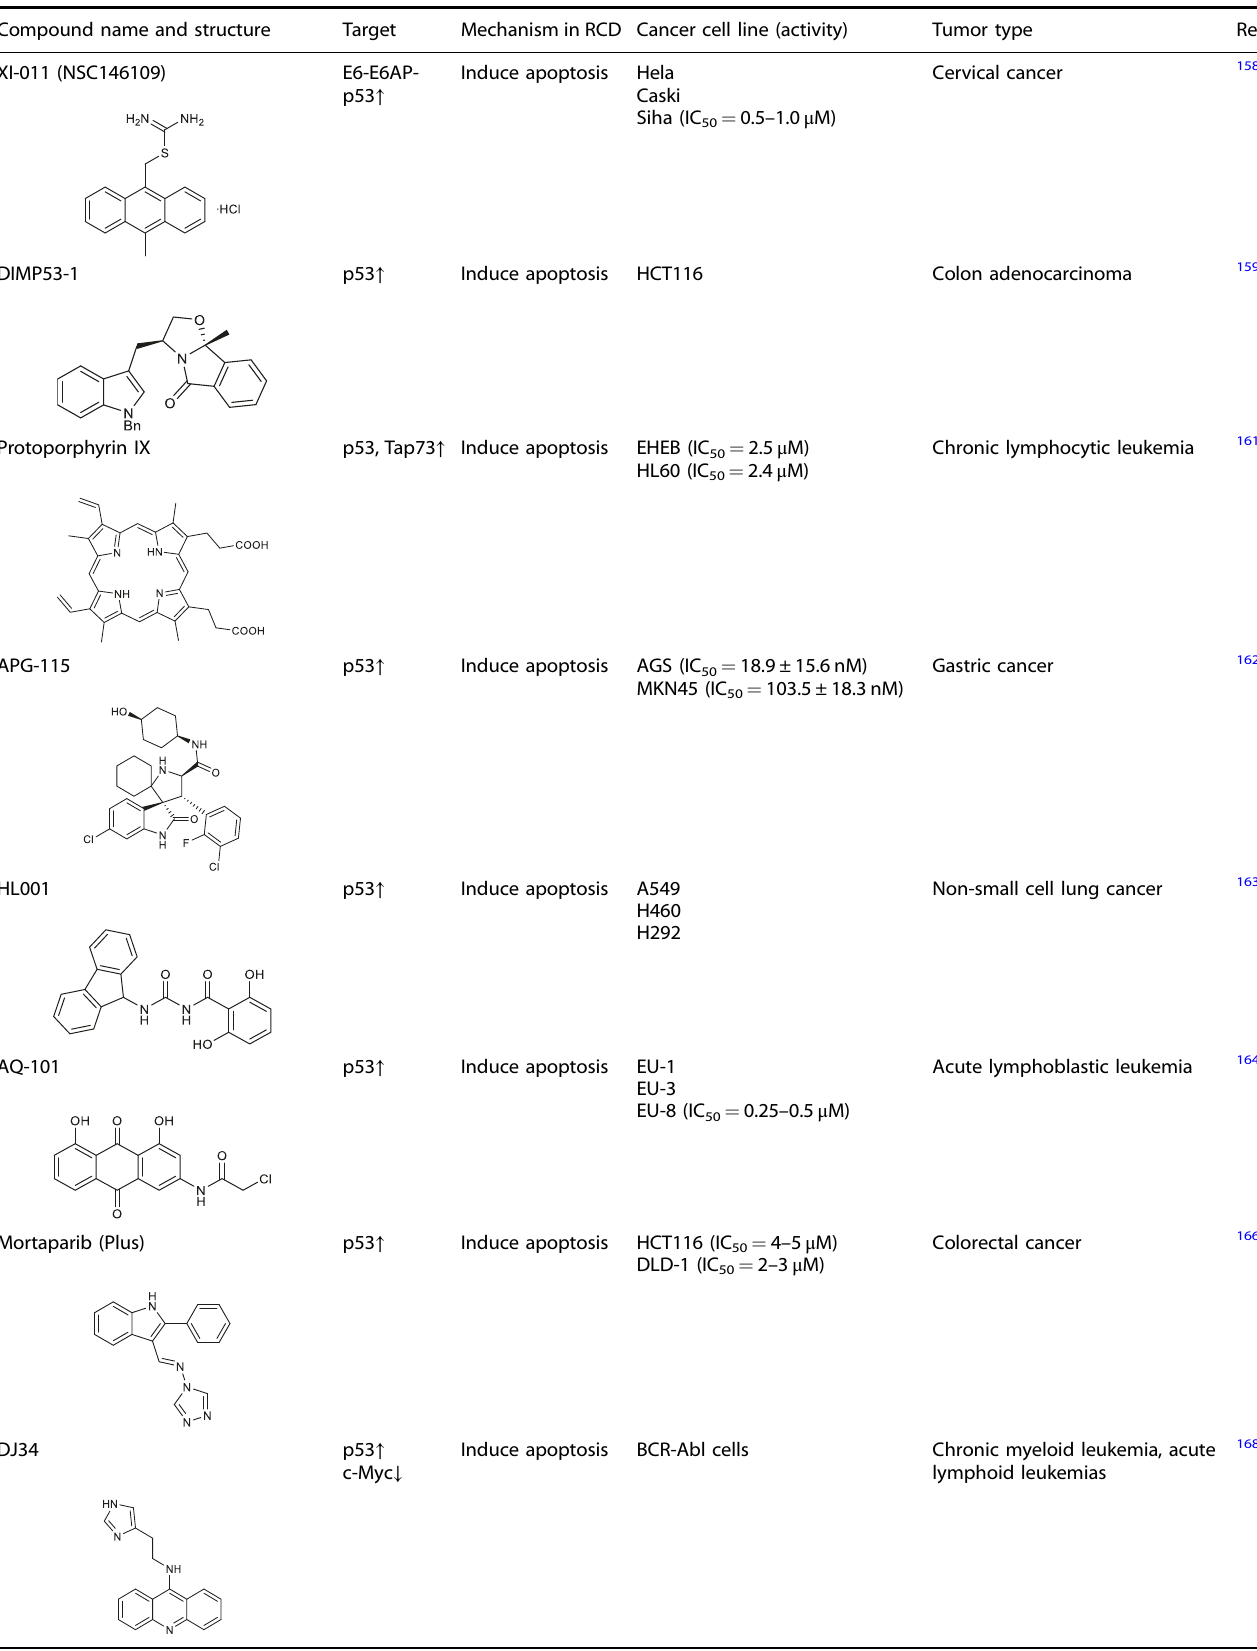
Table 5. Compounds targeting p53 in cancer Compound name and